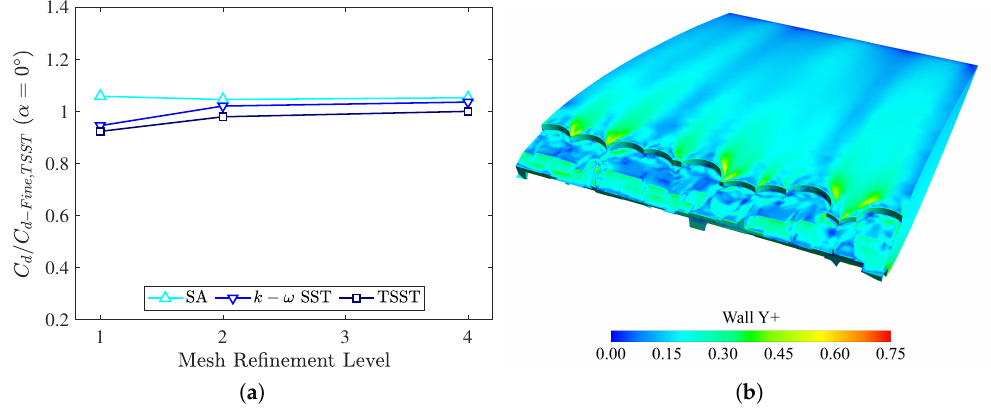
Figure 10. Three-dimensional model validation. ( a ) CFD-computed drag coefficient of the damaged blade as a function of the turbulence model and the mesh refinement level; ( b ) Wall y + contour obtained with the finest grid and the TSST model at 0 ◦